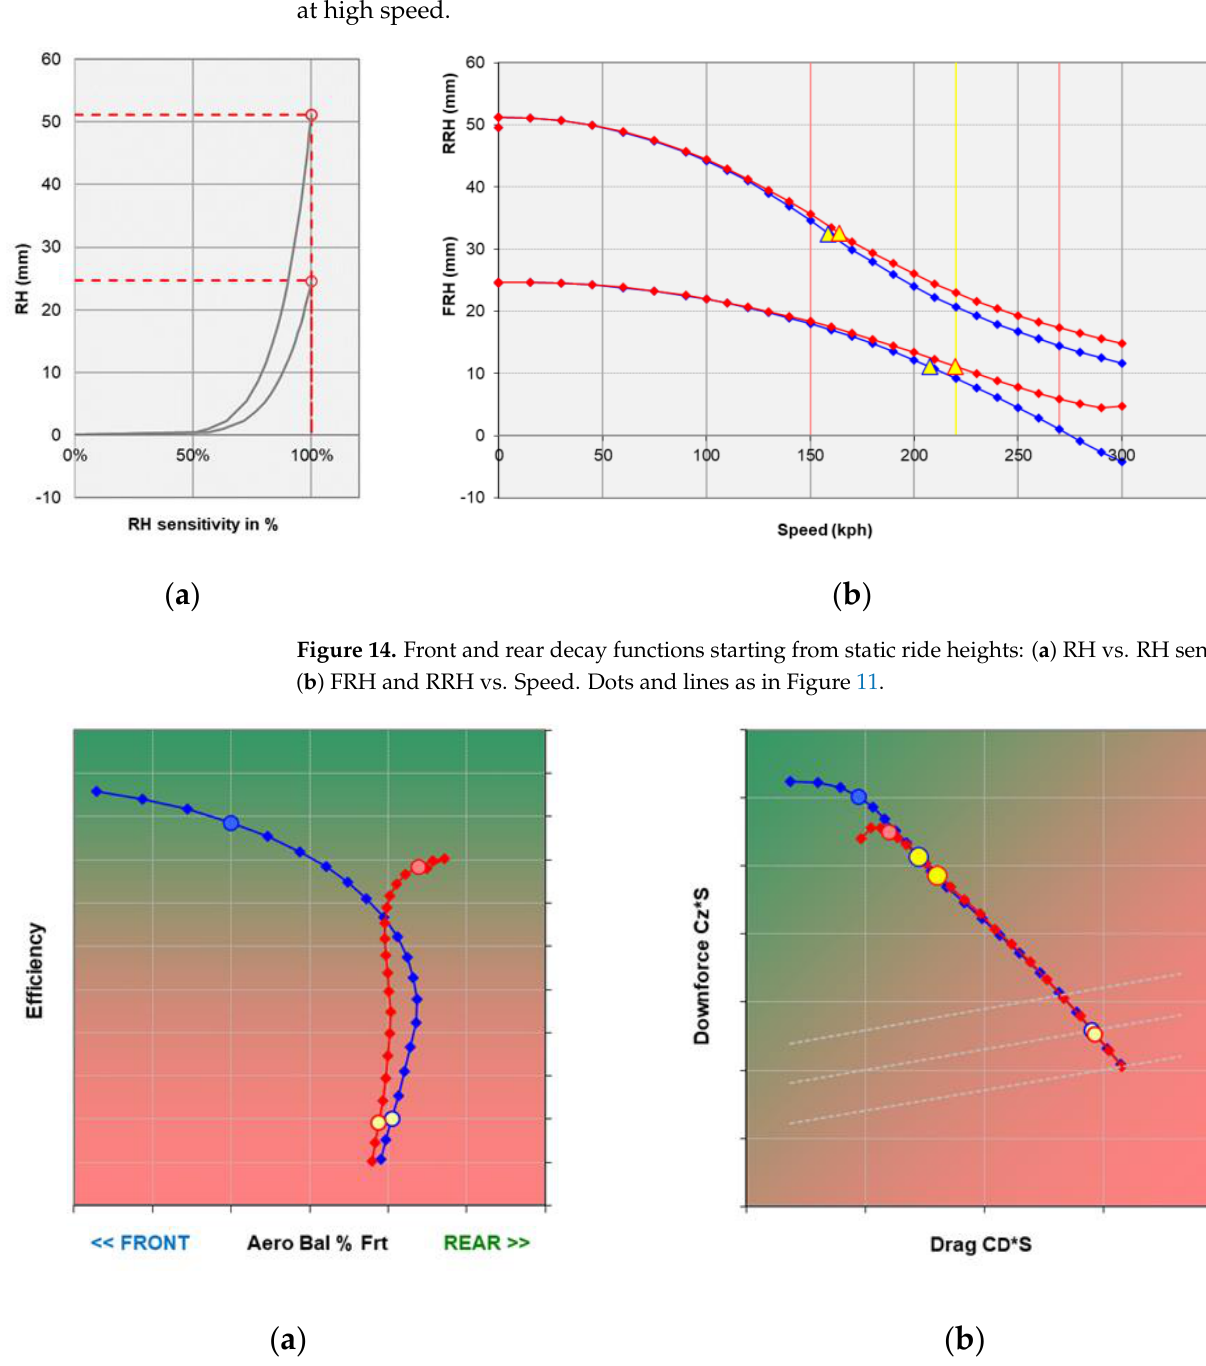
Figure 15. Decay effect on ride heights as a function of vehicle speed: ( a ) efficiency vs. aero balance; ( b ) downforce vs. drag. Yellow dots are speed references relevant to a specific